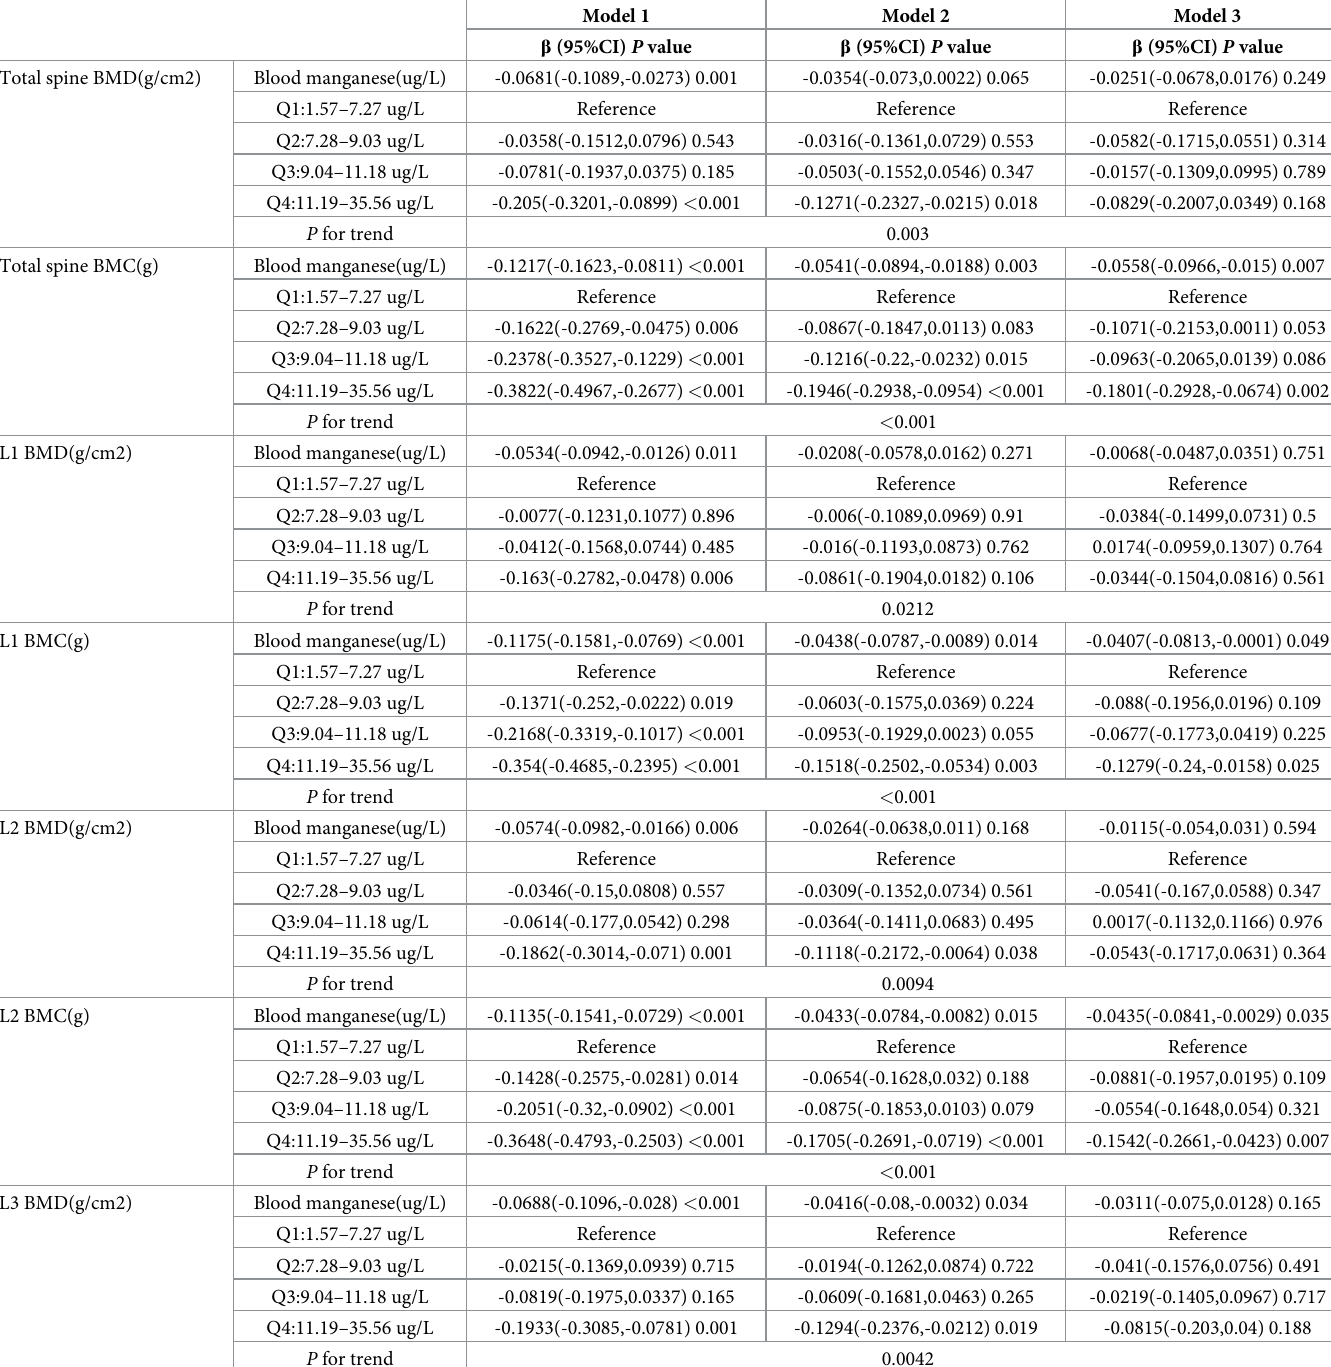
Table 2. The relationship between blood manganese and BMD/BMC in